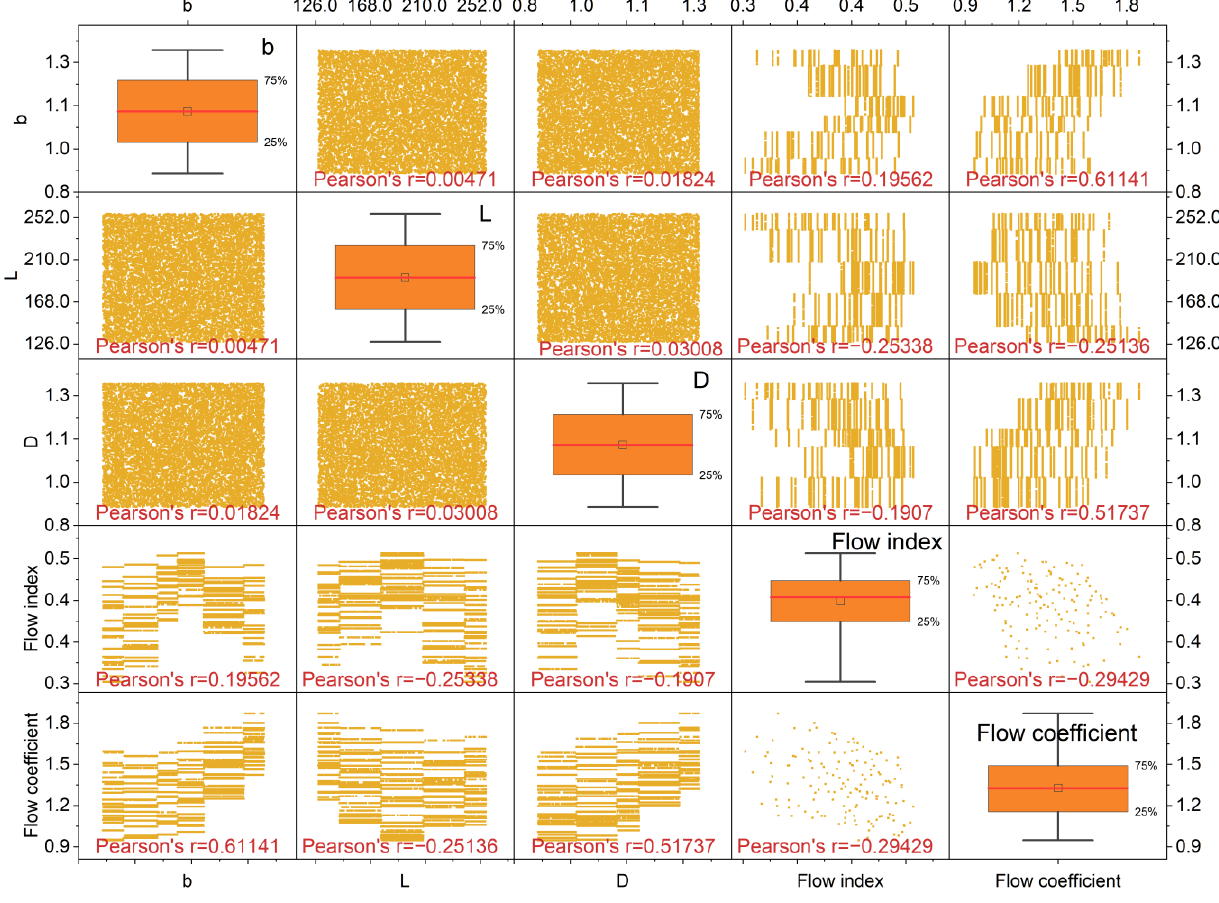
Figure 11. Structure parameters and hydraulic characteristics parameters correlation chart.